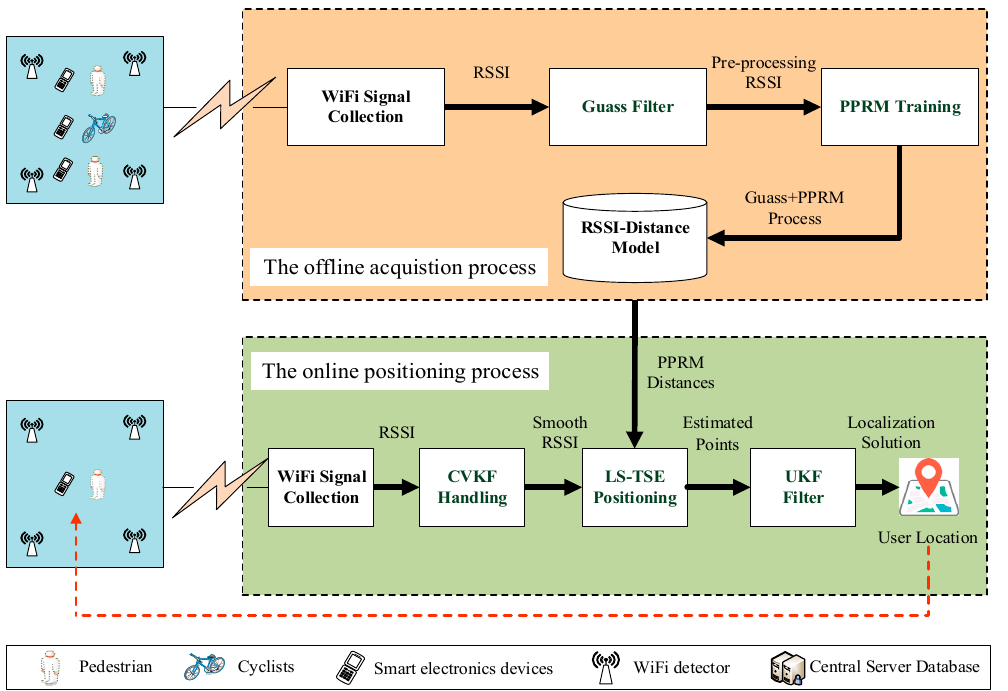
Figure 1. The proposed localization system framework.